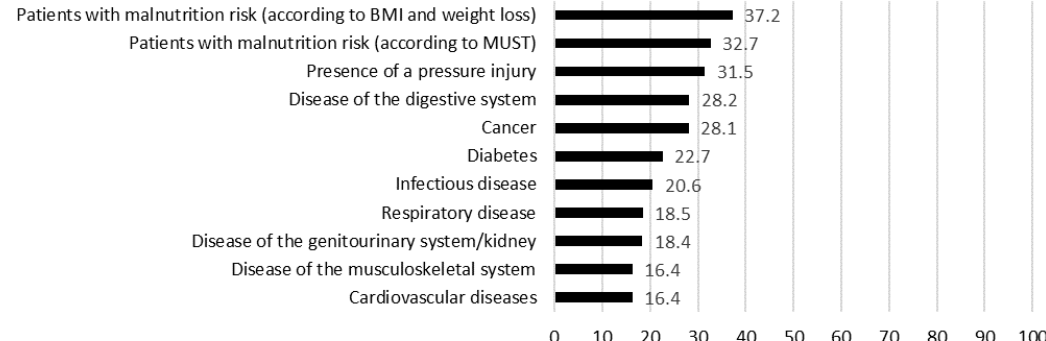
Figure 1. Frequency of dietitian referrals in different medical conditions; MUST = malnutrition universal screening tool; BMI = body mass index. Table 2. Predictors for dietitian referral, univariate binary logistic regression (BLR), and multivariate generalized estimating equation model (GEE).